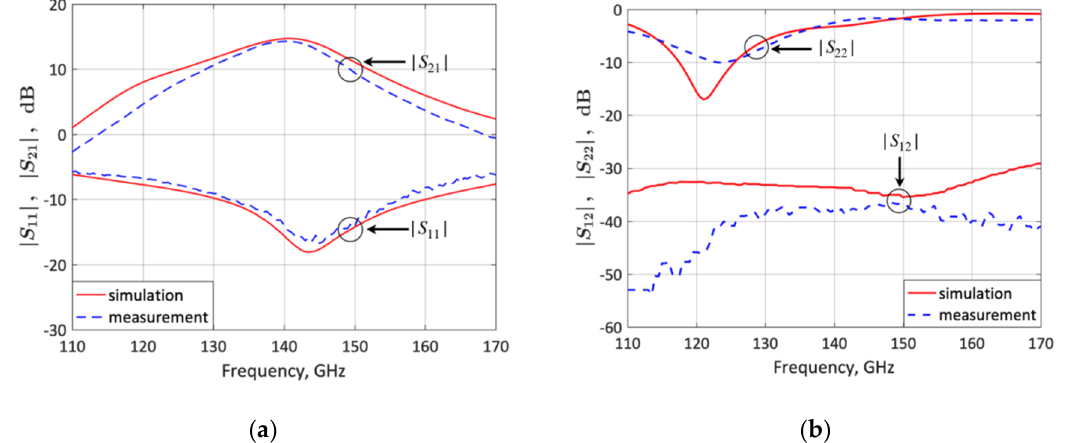
Figure 10. Measured and simulated LNA S-parameters for the upper-frequency state (140 GHz). ( a ) S 21 and S 11 ; ( b ) S 12 and S 22 .